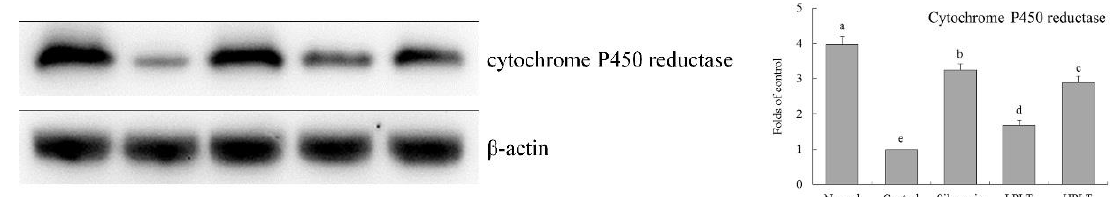
Figure 6. Cytochrome P450 reductase protein expression in hepatic tissue of experimental mice with CCl 4 -induced hepatic damage. Values presented are the means ± standard deviation ( N = 3/group). a–e Mean values with different letters in the same bars are significantly different ( p < 0.05) and those with the same letter in the same column are not significantly different ( p > 0.05) according to Duncan’s new MRT. Silymarin group: 50 mg/kg b.w. silymarin treatment dose; LPLT group: 50 mg/kg b.w. polyphenols of Liubao tea (PLT) treatment dose; and HPLT group: 100 mg/kg b.w. polyphenols of Liubao tea (PLT) treatment dose.